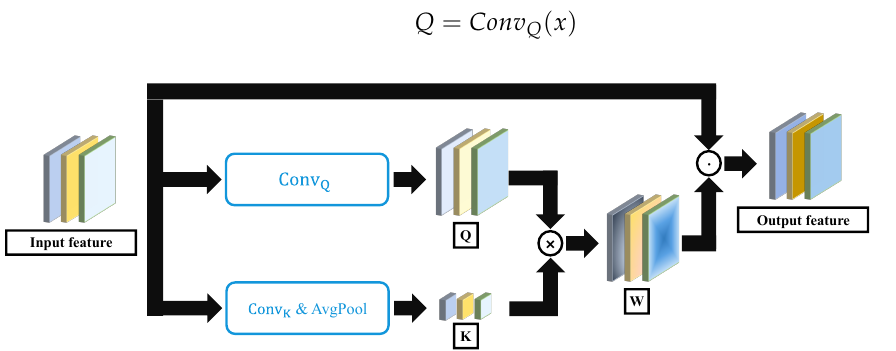
Figure 3. Single-key global spatial attention. We utilize a similar idea to self-attention, but the difference is that the spatial dimension of the key collapses in our approach, and each spatially located feature has to interact with only one feature instead of interacting with all features as in self-attention. We use the idea of weighting similar to SE attention [41] to weight the important features, instead of the feature generation method in